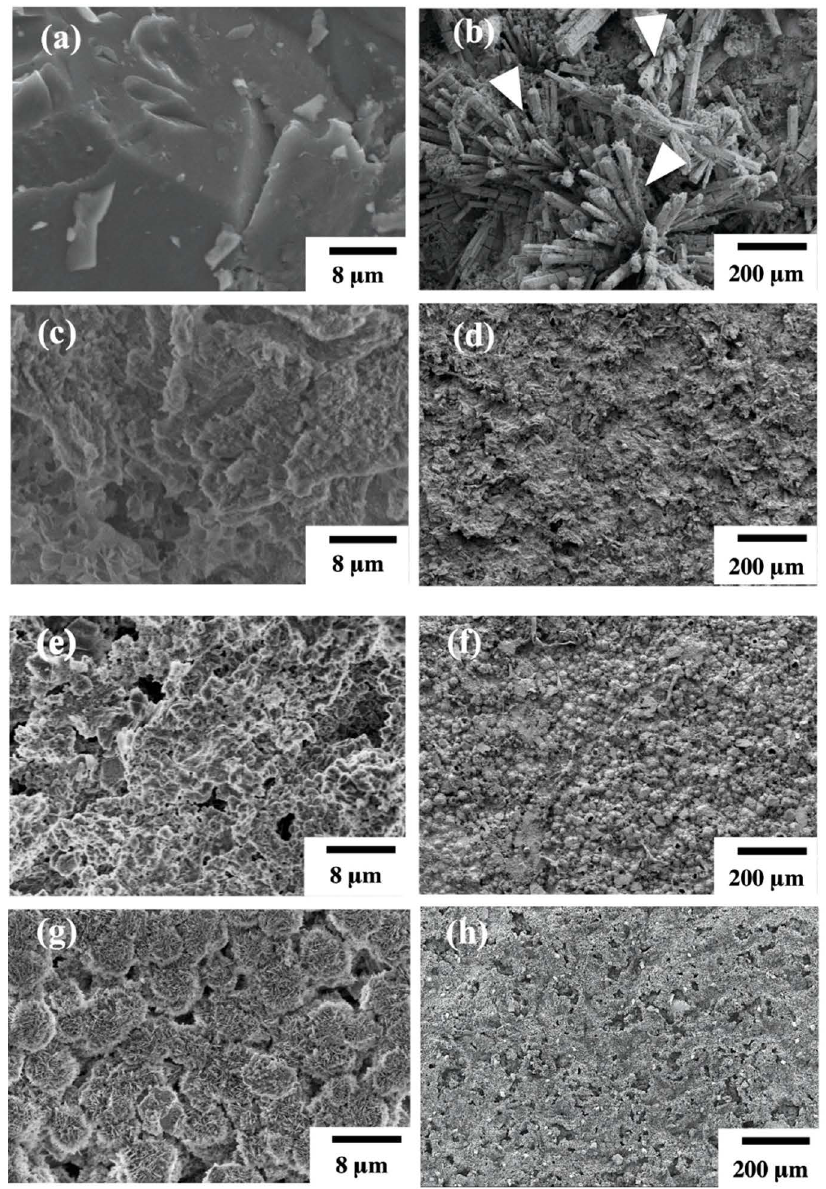
Figure 1. Surface morphologies of the uncoated Mg scaffold ( a ) before incubation (3000 × magni- fication) and ( b ) after incubation (100 × magnification). Surface morphologies of hydrothermally coated ( c ) Mg(OH) 2 -Mg, ( e ) HA-Mg, and ( g ) FHA-Mg scaffolds before incubation and ( d , f , h )